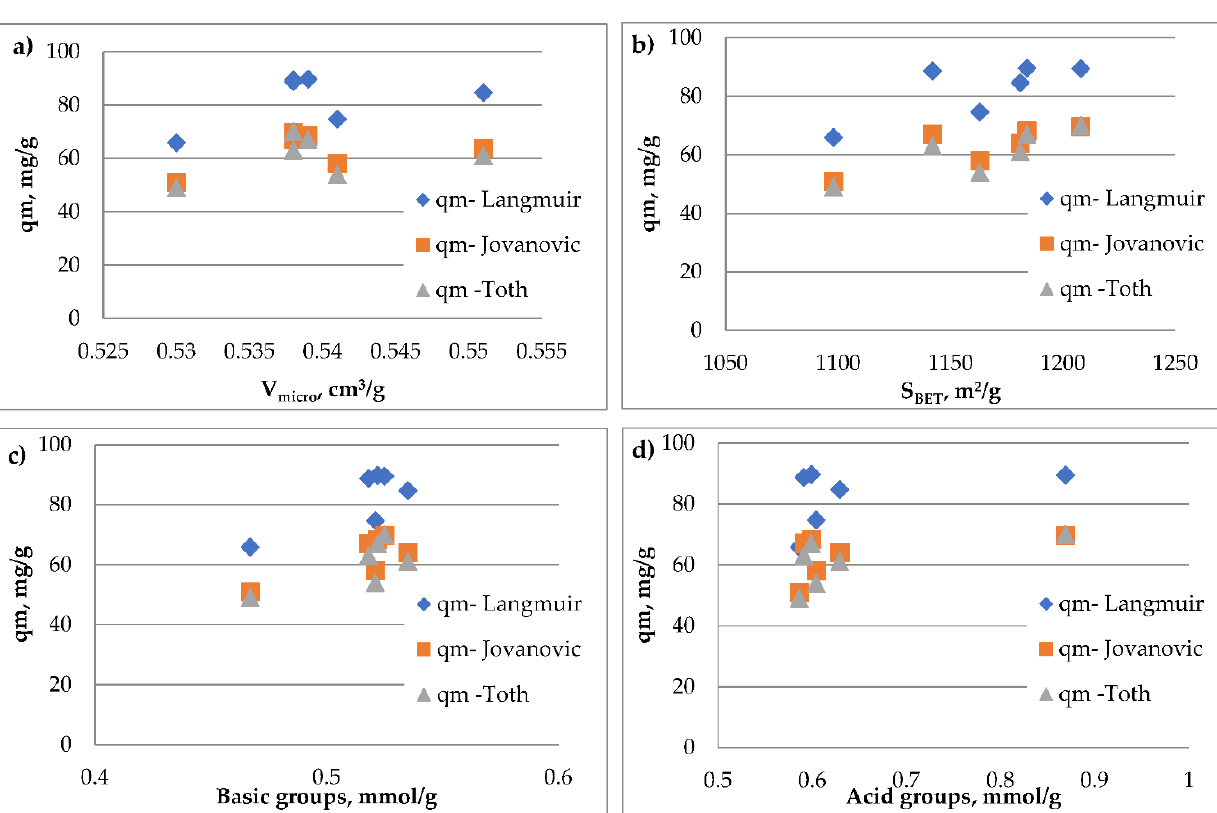
Figure 10. The dependence of the adsorption capacity on: ( a ) the specific surface area; ( b ) micropores volume, ( c ) basic groups, ( d ) acid groups.